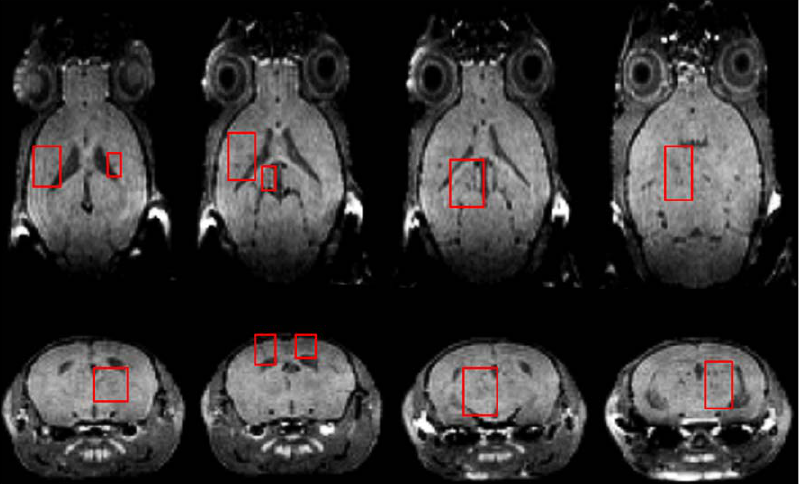
Figure 1. Example for T1 black hole formation in 7-day TMEV infected C57BL/6J mice. Top row: axial images, bottom row: coronal images extracted from a representative mouse. To provide guidance, some (but not all) areas containing T1 black holes are indicated with red frames. These are located in diverse areas of the brain, but mostly in periventricular areas, in the thalamus, hippocampus, white matter, corpus callosum and even in the